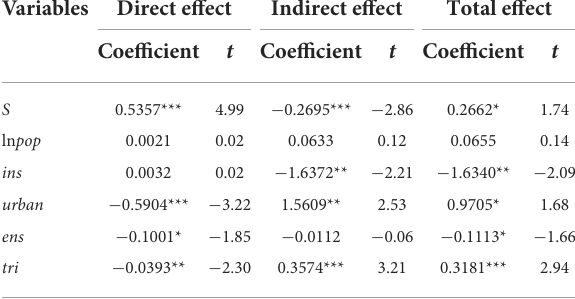
TABLE 9 Direct, indirect and total effects of technological innovation on TCEE.